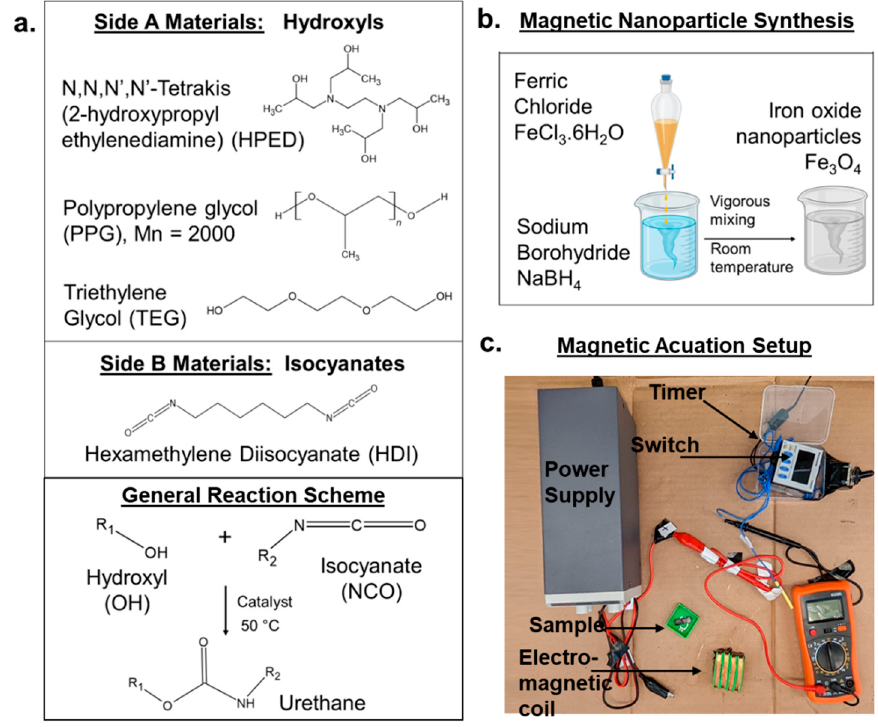
Figure 1. ( a ) Polymer component structures and overview of the synthesis of polyurethane SMP. ( b ) Overview of the synthesis of magnetic nanoparticles. ( c ) Magnetic circuit setup employed for magnetic actuation of SMPs.